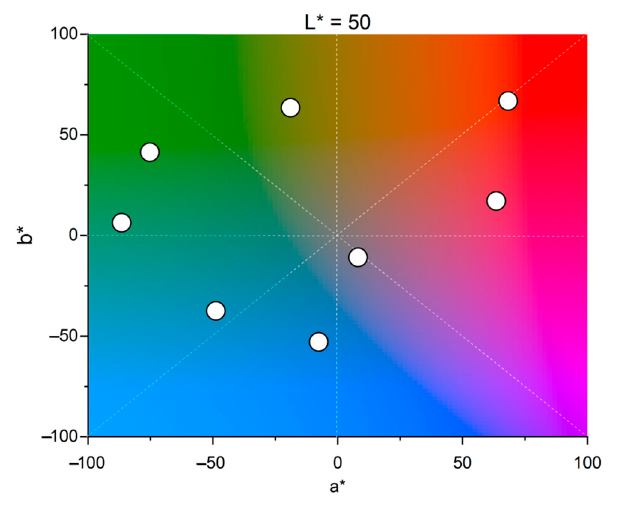
Figure 1. CIELAB coordinates for the eight dyes created projected on a L* = 50 plane.